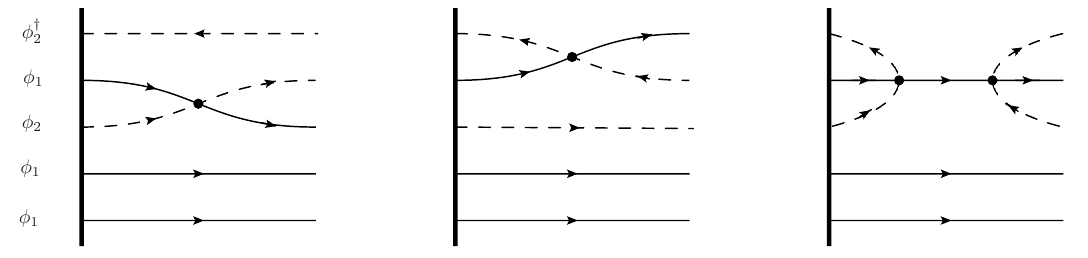
Figure 9 . Mixing of O 3 = tr( (cid:30) y coupling. Three diagrams correspond to three transitions de(cid:12)ned in (7.16). Solid line denotes (cid:12)eld (cid:30) 1 , dashed line represents (cid:30) 2 and (cid:30) y